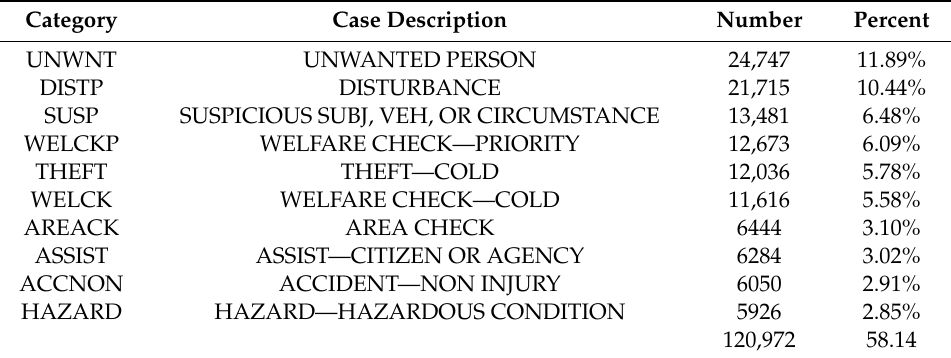
Table 5. Frequencies of Top-10 call categories.